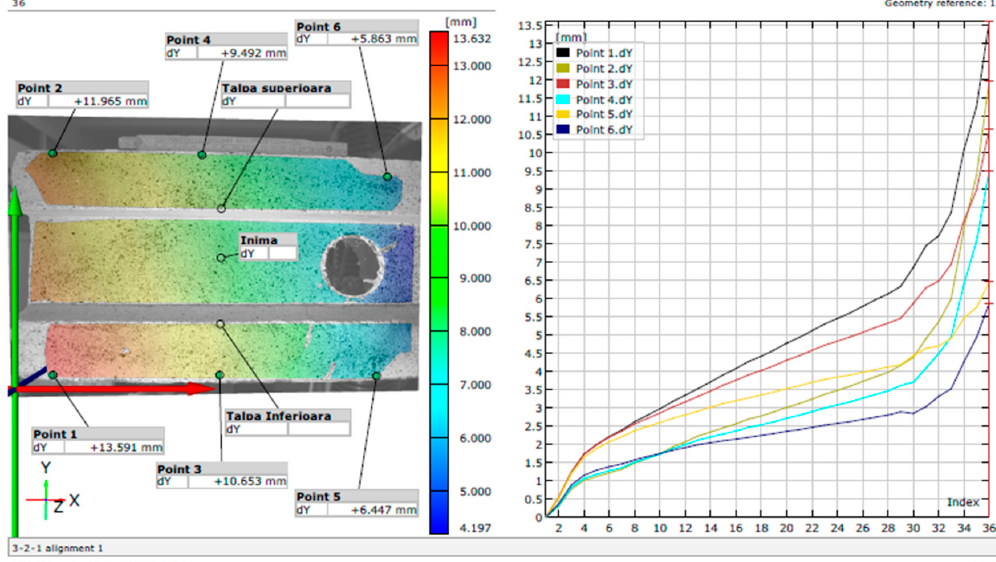
Figure 7. Vertical displacements of the limestone beam (GR-3-FC) analyzed with GOM Correlate.